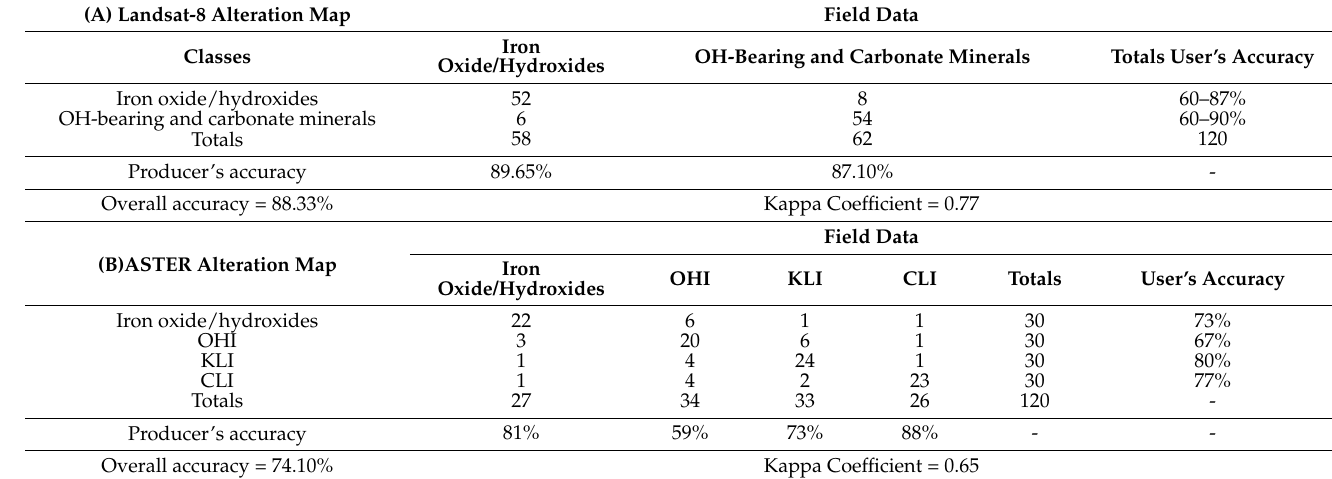
Table 4. Error matrix for alteration mapping derived from remote sensing data versus field data. ( A ) Landsat-8 data; ( B ) ASTER data.